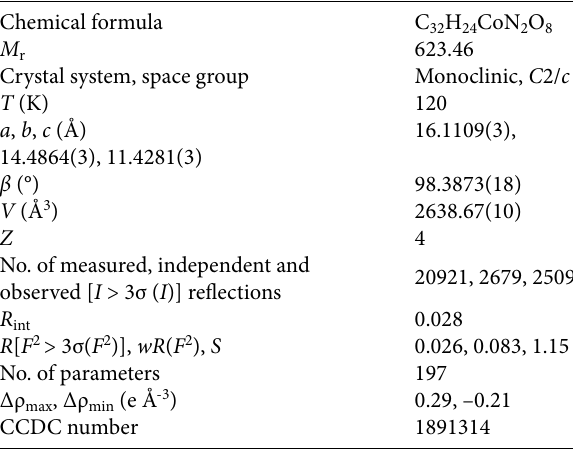
Table 1. Crystallographic details and structure refinement of com- plex Chemical